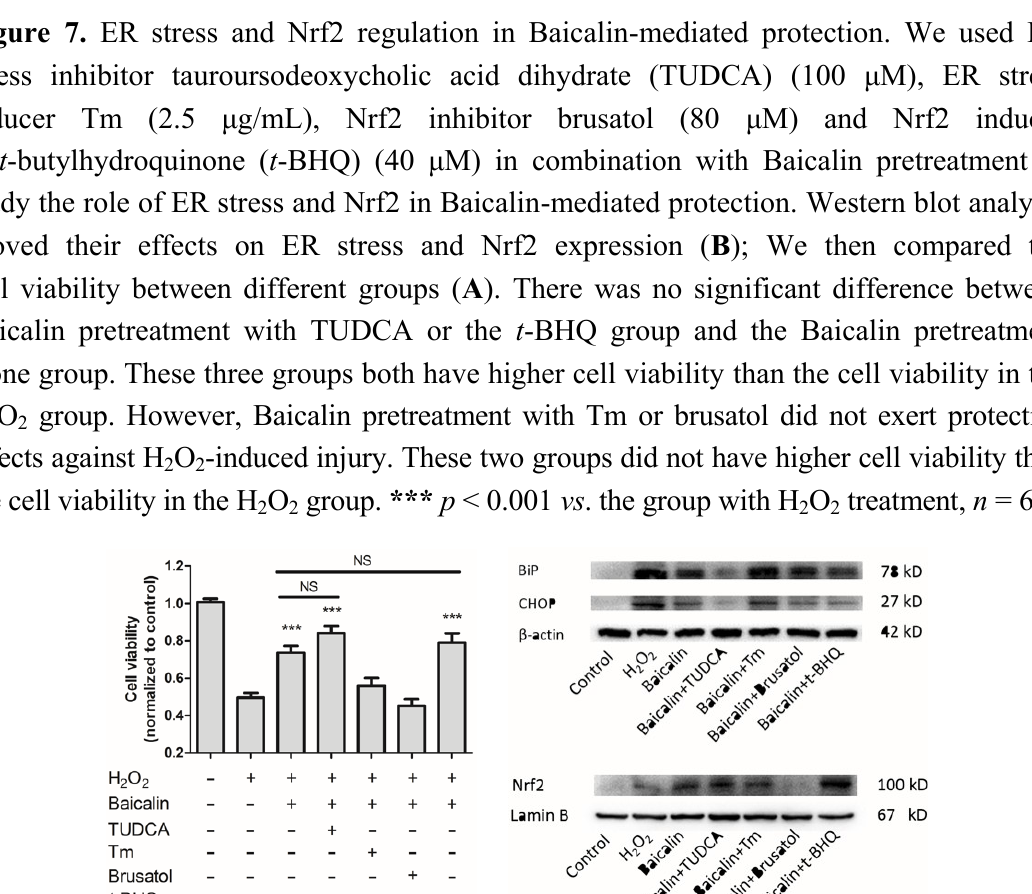
Figure 7. ER stress and Nrf2 regulation in Baicalin-mediated protection. We used ER stress inhibitor tauroursodeoxycholic acid dihydrate (TUDCA) (100 μM), ER stress